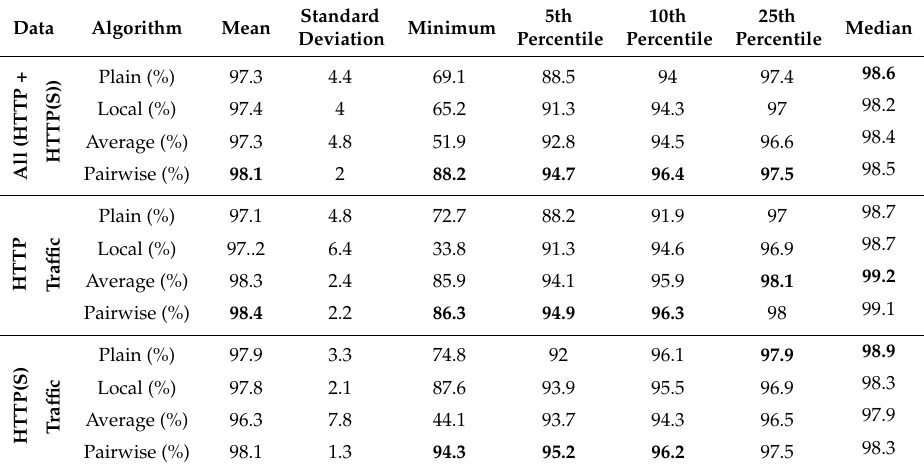
Table 4. Comparison of AUCs of per-flow anomaly